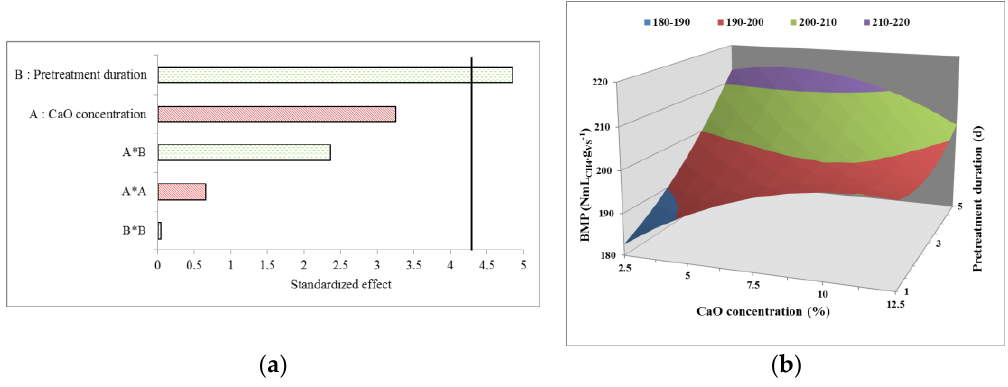
Figure 3. Pareto diagram showing the effect of different coefficient terms on BMP ( a ) and response surface plot showing the impact of lime concentration and pretreatment duration on BMP in Design 2 ( b ).